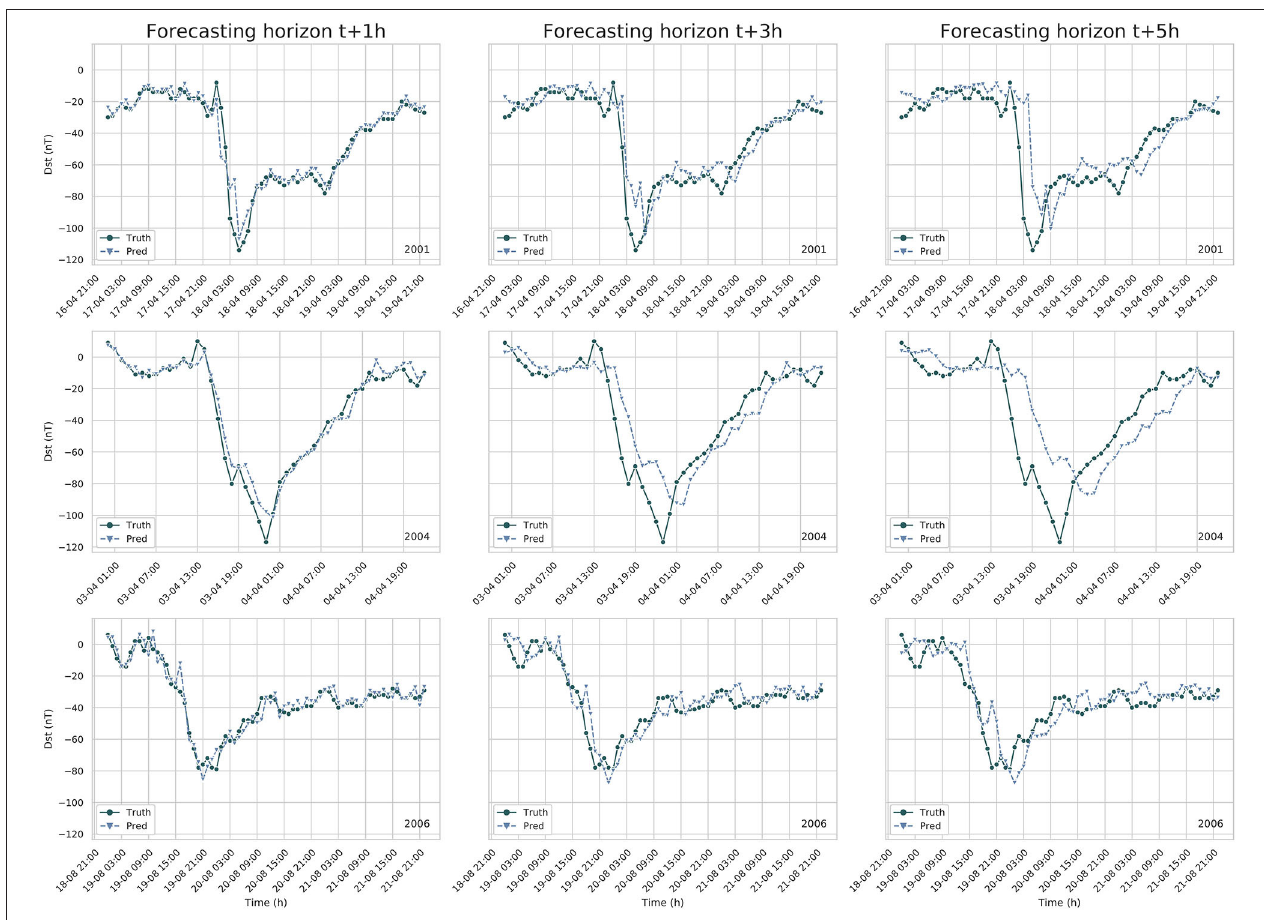
FIGURE 3 | Forecast of the LSTM-NN model for three separate geomagnetic storm events. Each plot shows the observed Dst index (Truth) and the forecast Dst index (Pred). Every row shows the same storm, and every column corresponds to a different forecaseting horizon. Notice that the LSTM-NN model systematically forecasts the main phase of the storm too late by a number of hours equivalent to the forecasting